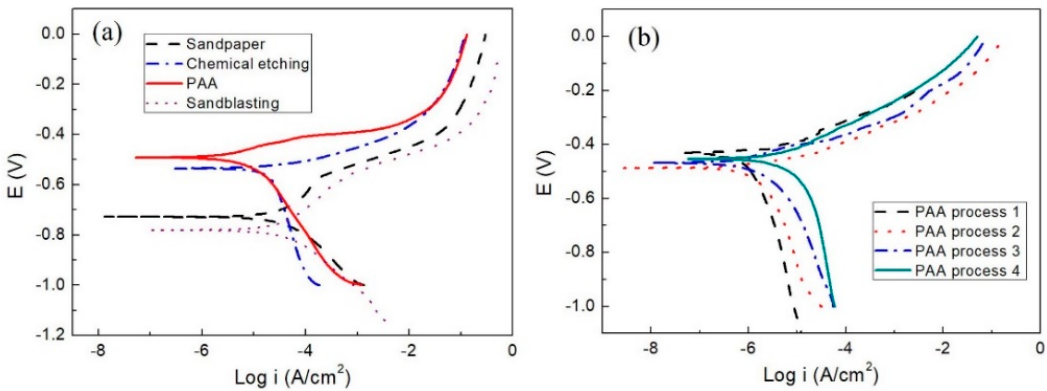
Table 5. Effect of surface treatments on corrosion resistant and durability. Figure 13. Polarization curves of Al − Li substrates created by ( a ) di ff erent surface treatments and Figure 13. Polarization curves of Al − Li substrates created by ( a ) different surface treatments and ( b ) ( b ) phosphoric acid anodization (PAA) on substrates of di ff erent roughnesses.